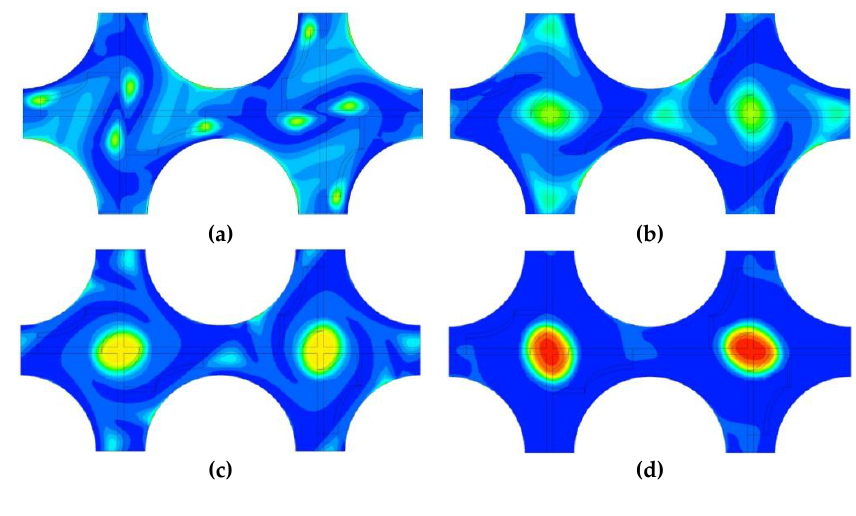
Figure 4. Vapor fraction at downstream of vaned spacer for case 1: ( a ) L = 0.01 m, ( b ) L = 0.05 m, ( c ) L = 0.08 m, ( d ) L = 0.10 m, ( e ) L = 0.15 m ( L is defined as the distance between the down surface of vane and the corresponding plane).